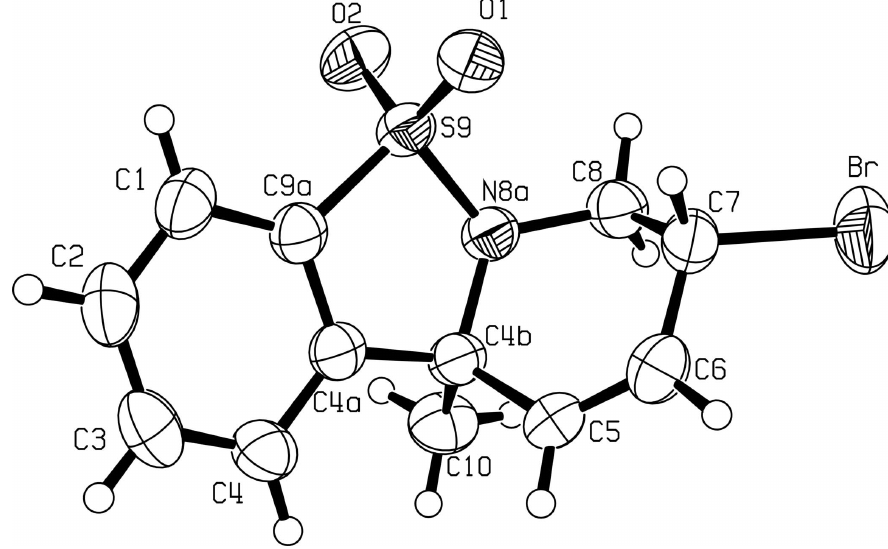
The molecular structure of (I) is drawn with 50% probability displacement ellipsoids for non-hydrogen atoms. The hydrogen atoms are drawn with an artificial